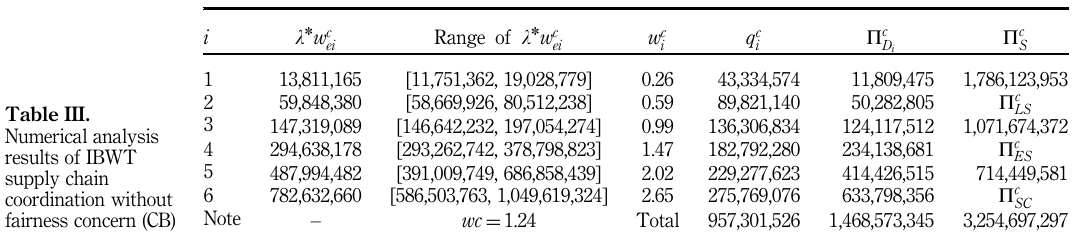
Table II. Numerical analysis results of IBWT supply chain coordination without fairness concern (CNB)